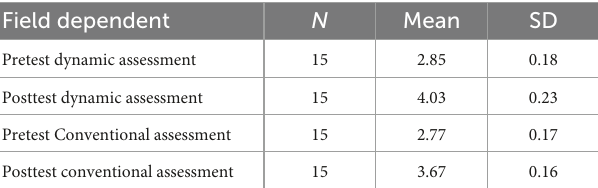
TABLE 1 Descriptive statistics for pretest and posttest mean scores of Field Dependent learners with dynamic assessment and conventional